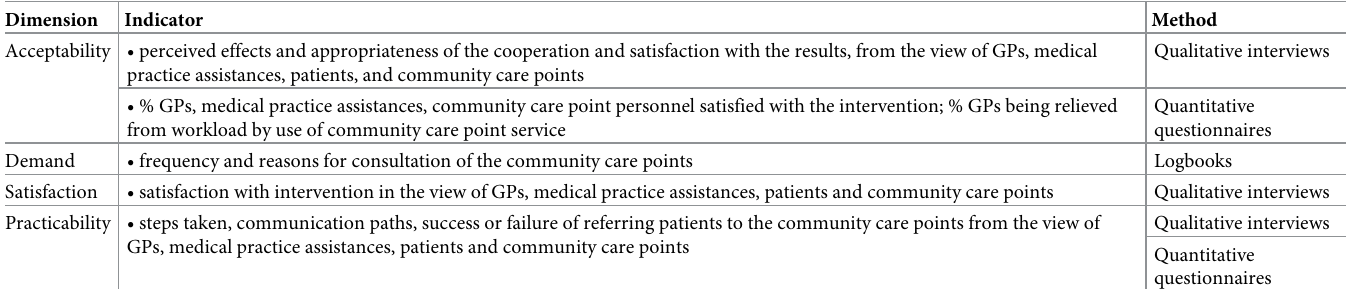
Table 2. Dimensions, indicators of feasibility and methods in COMPASS